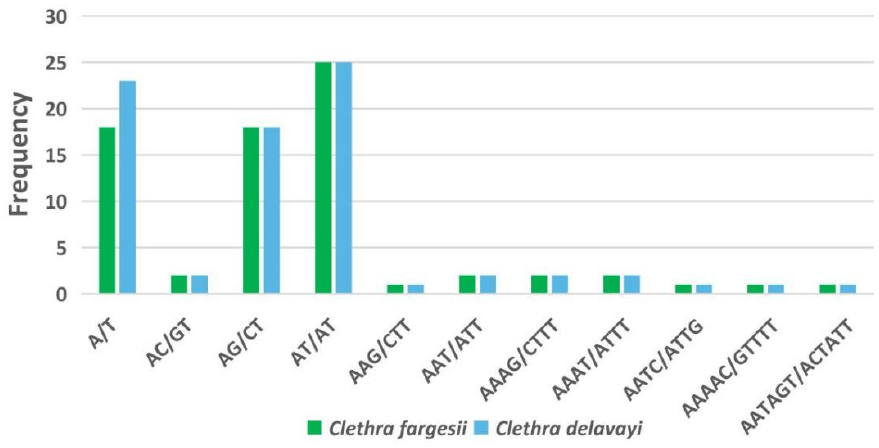
Figure 7. The number of different SSR units in the chloroplast genome of C. fargesii and C. delavayi .